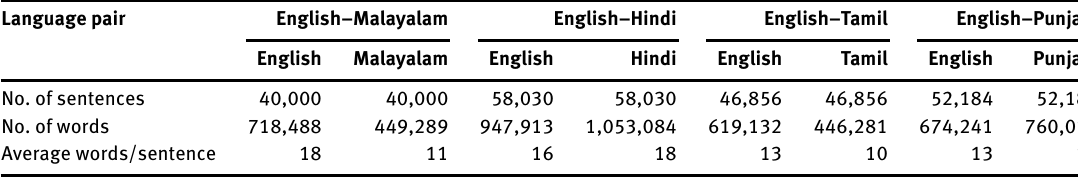
Table 1: No. of Sentences, No. of Words, and Average Sentence Length in Four Language Pairs. Language pair